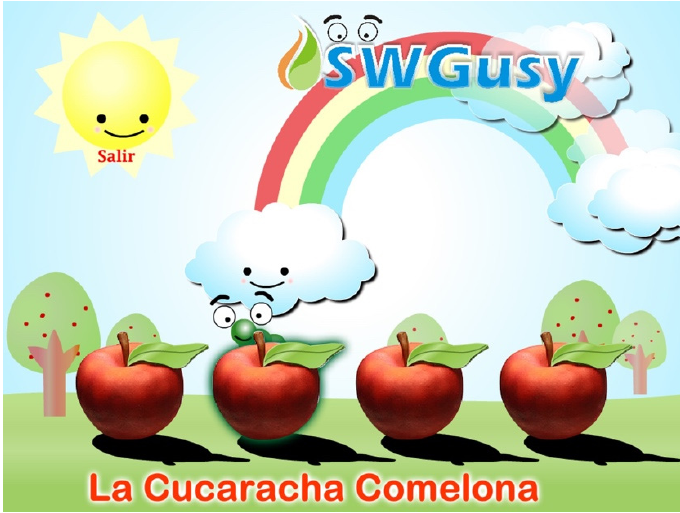
Figure 5. Initial screen of the playful application.